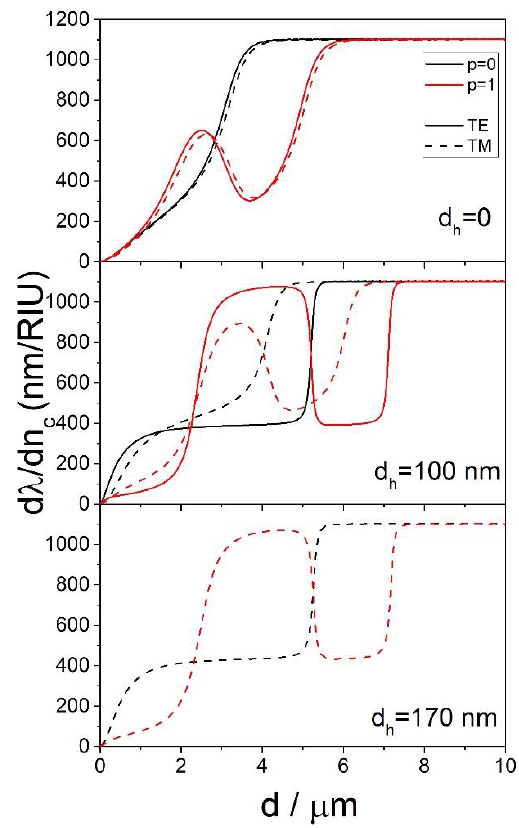
Figure 10. The dependence of ∂λ / ∂ n c on d for n c = 1.4, n h = 1.9 and D = 150 µ m for the TE and TM modes calculated for select values of p and d h .